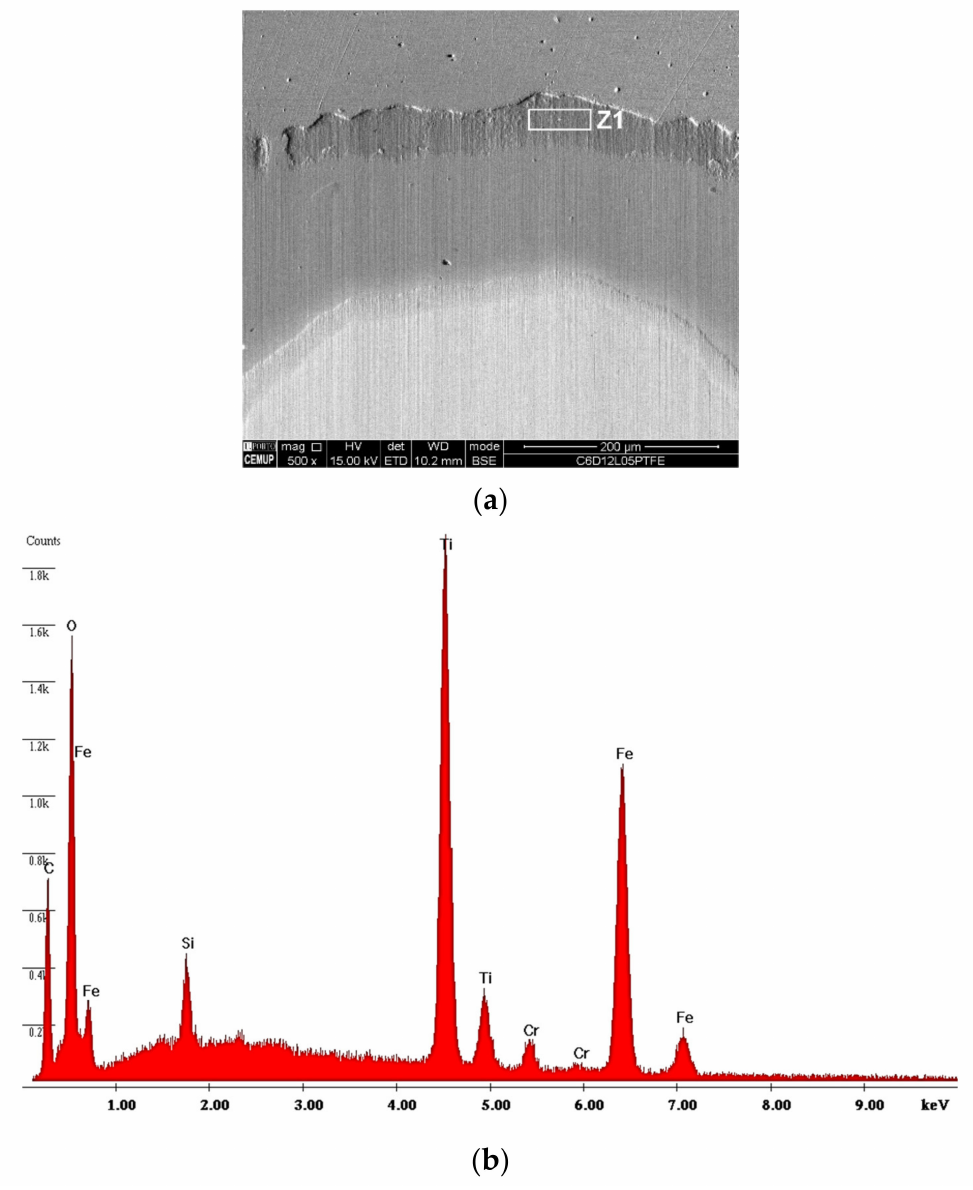
Figure 14. Detail of a wear crater generated by PTFE balls for diamond abrasive particles (1–2 µ m) with a 0.5 N load: ( a ) crater inlet and ( b ) corresponding EDS spectrum in the Z1 zone indicating the presence of